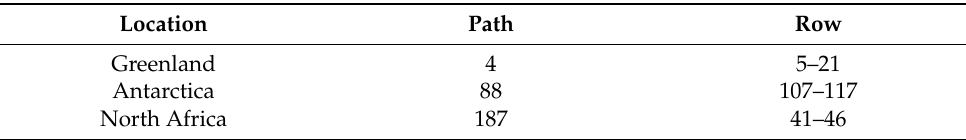
Table 3. Summary of side-slither path/row location acquisition. Location Path